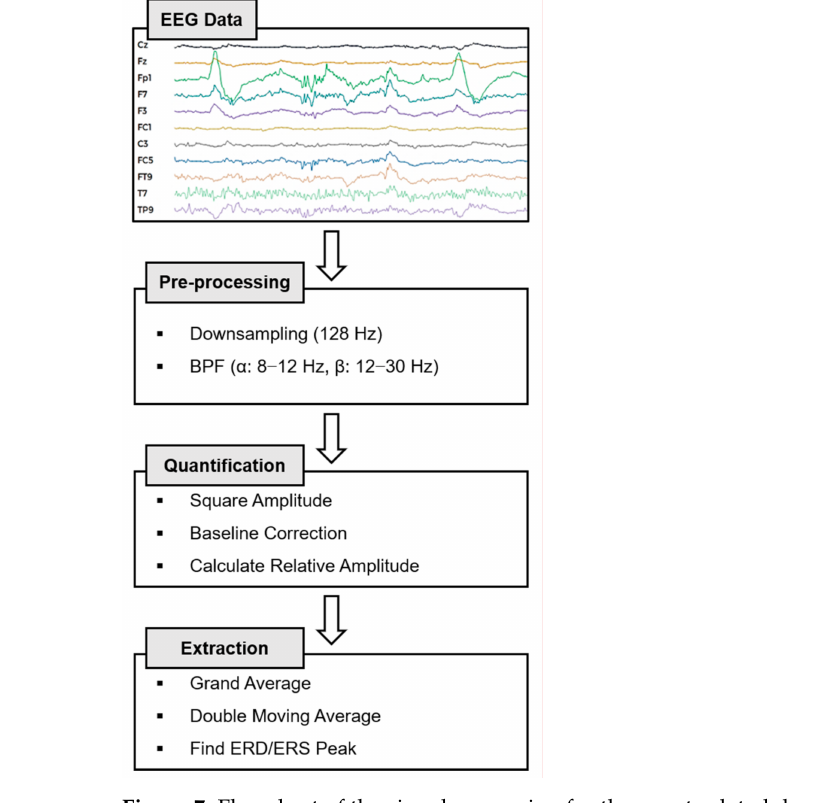
Figure 7. Flowchart of the signal processing for the event-related desynchronization (ERD)/event- related synchronization (ERS)